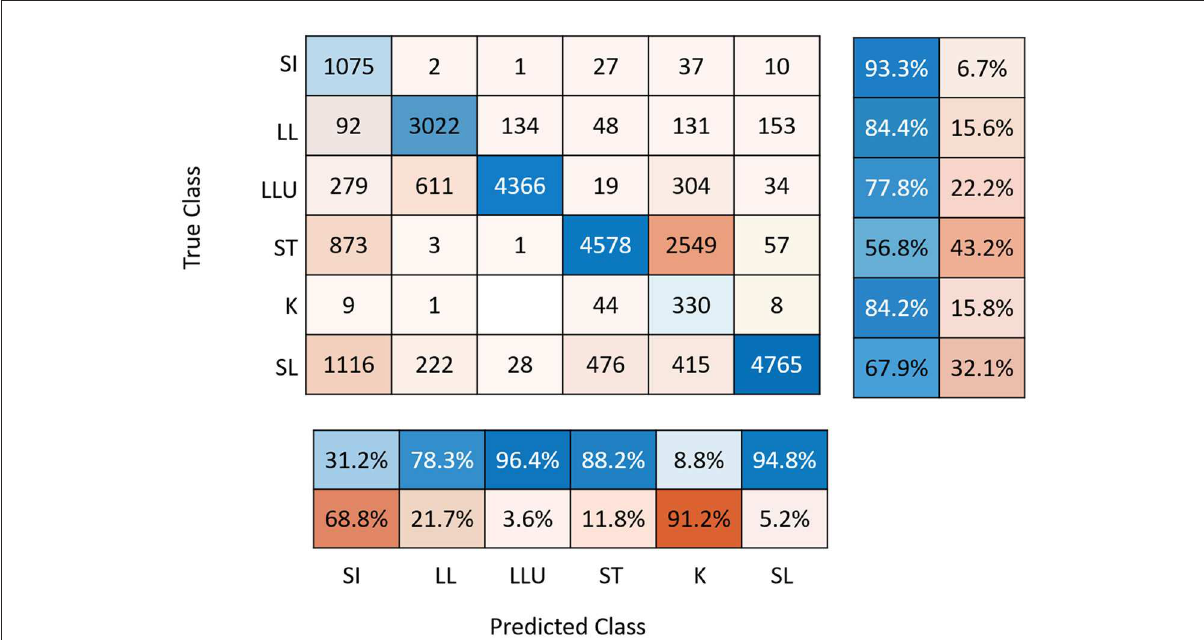
FIGURE2 Confusion matrix associated with YOLO prediction with sensitivity (right panel) and precision (below panel) . SI, sitting; LL, lateral lying; LLU, lateral lying with udder exposed; ST, standing; K, kneeling; SL, sternal